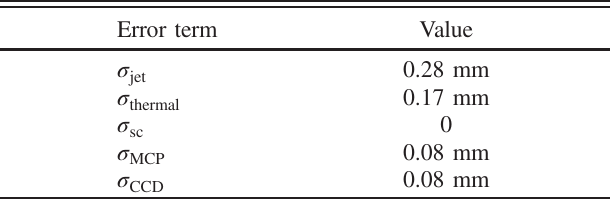
TABLE I. Summary of the image broadening terms for the